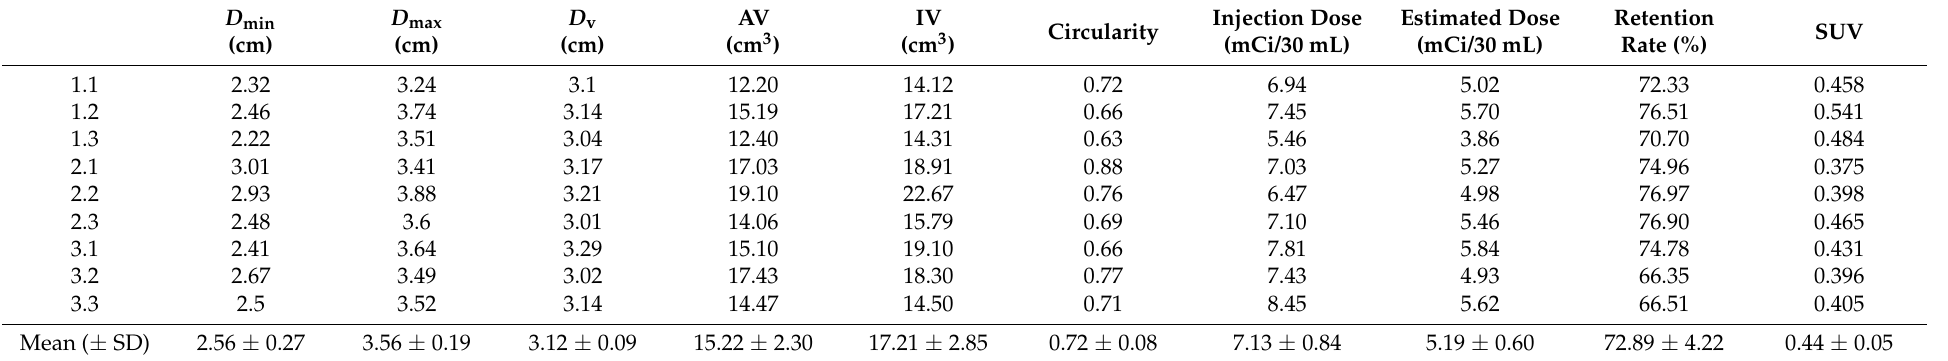
Data are shown as means ± standard deviation (SD). D min , minimum diameter of the ablation zone; D max , maximum diameter of the ablation zone; D v , vertical diameter of the ablation zone; AV, the ablated volumes; IV, the image volume measured on PET-MR; circularity, the ratio between the D max and D min ; retention rate = (estimated dose/injection dose) × 100, SUV, standard uptake value; there was significant difference between AV and IV ( p =